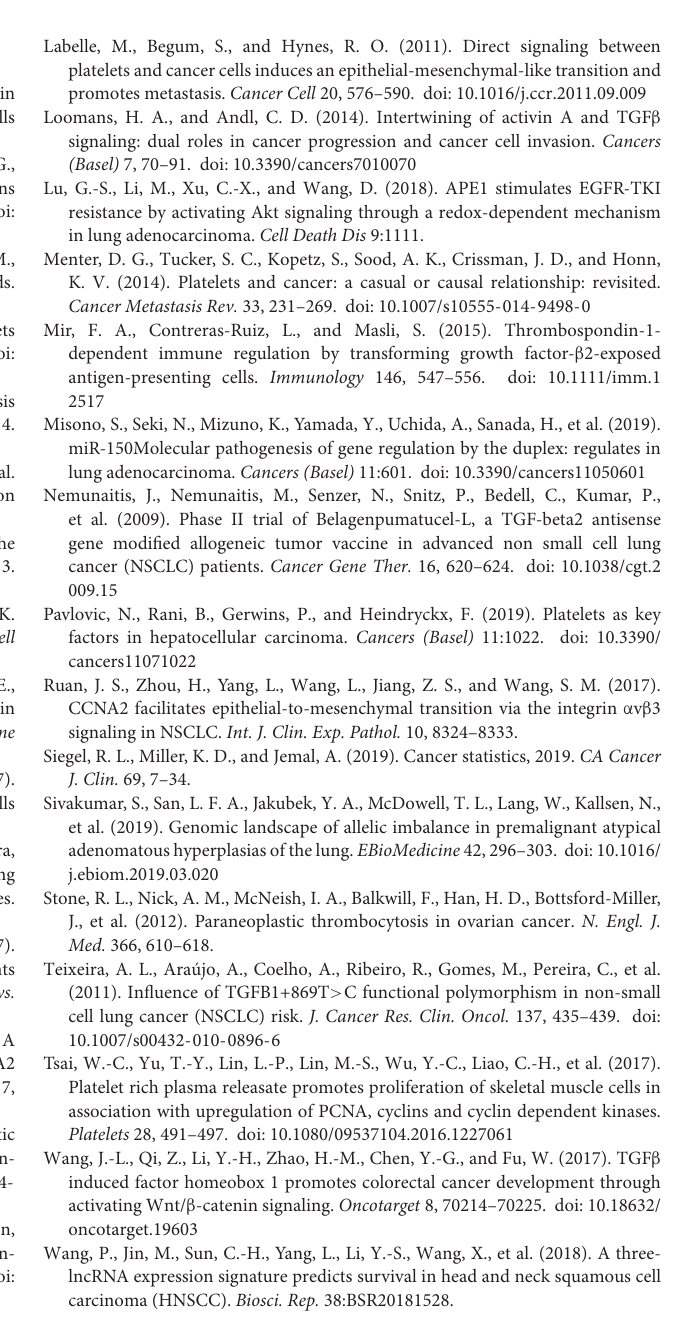
Supplementary Figure 1 | Operating Page of nomogram Online Web Page Prediction Tool Based on Risk Score and Clinical Characteristics. (A) Upload data operation page; (B) Patient Information Operation Interface Personalized Selection; (C) Forecast result interface. Supplementary Figure 2 | Correlation between Risk Score and other seven cancers. Supplementary Figure 3 | Meta-analysis on the difference of tissue expression of TGFB2 and CCNA2. Supplementary Figure 4 | Meta-analysis on the survival analysis of TGFB2 and